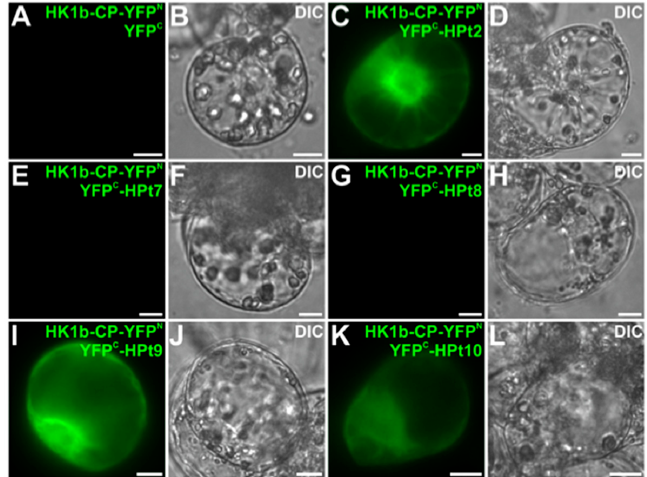
Figure 5. Analysis of HK1b-CP/HPts interactions in Bimolecular Fluorescent Complementation (BiFC) assays. Cells were co-transformed using a combination of plasmids expressing HK1b-CP/HPt2 ( C , D ), HK1b-CP/HPt7 ( E , F ), HK1b-CP/HPt8 ( G , H ), HK1b-CP/HPt9 ( I , J ) and HK1b-CP/HPt10 ( K , L ) as indicated. As a negative control, the combination of plasmids expressing HK1b-CP/YFP C ( A , B ) was used. The morphology was observed by differential interference contrast (DIC) microscopy. Scale bar = 10 µm.